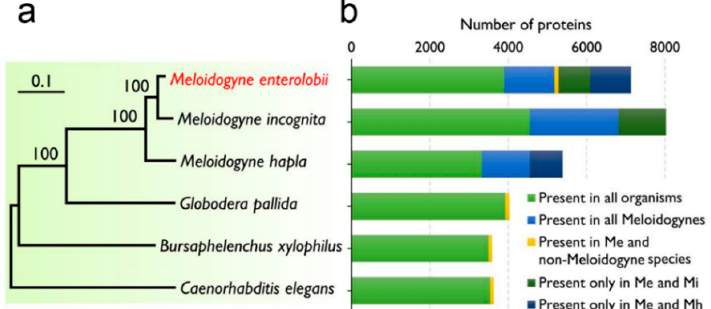
Figure 3. Phylogeny and ortholog distribution of six nematodes. ( a ) A genome-based phylogenetic tree generated with the neighbor-joining method; ( b ) The orthologous proteins identified in the species are represented using colored bars that are divided into five categories: present in all organisms (green), present in all Meloidogyne species (blue), present in M. enterolobii and non- Meloidogyne species (orange), present only in M. enterolobii and M. incognita (dark green) and present only in M. enterolobii and M. hapla (dark blue). Me: M. enterolobii ; Mi: M. incognita ; Mh: M. hapla .